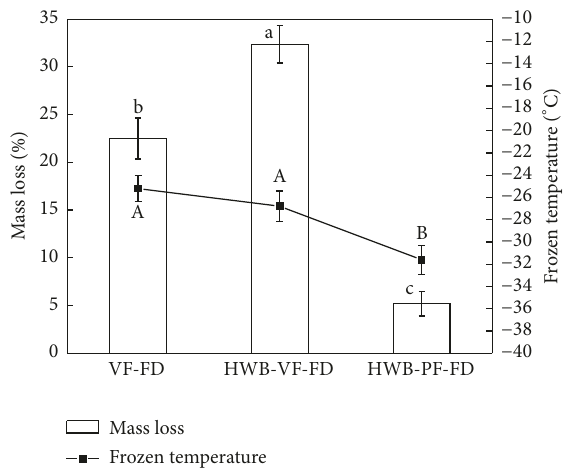
Figure 2: Mass loss and frozen temperature of apple samples at the end of freezing treatment in 3 freeze-drying methods. VF-FD: apple samples without hot-water pretreatment were performed with vacuum freezing treatment and freeze-drying process; HWB-VF- FD: apple samples with hot-water pretreatment were performed with vacuum freezing treatment and freeze-drying process; HWB- PF-FD: apple samples with hot-water pretreatment were performed with plate freezing treatment and freeze-drying process. Note . Dif- ferent letters on the same bar or line indicate significant differences at 𝑝 = 0.05 by Tukey’s HSD test.